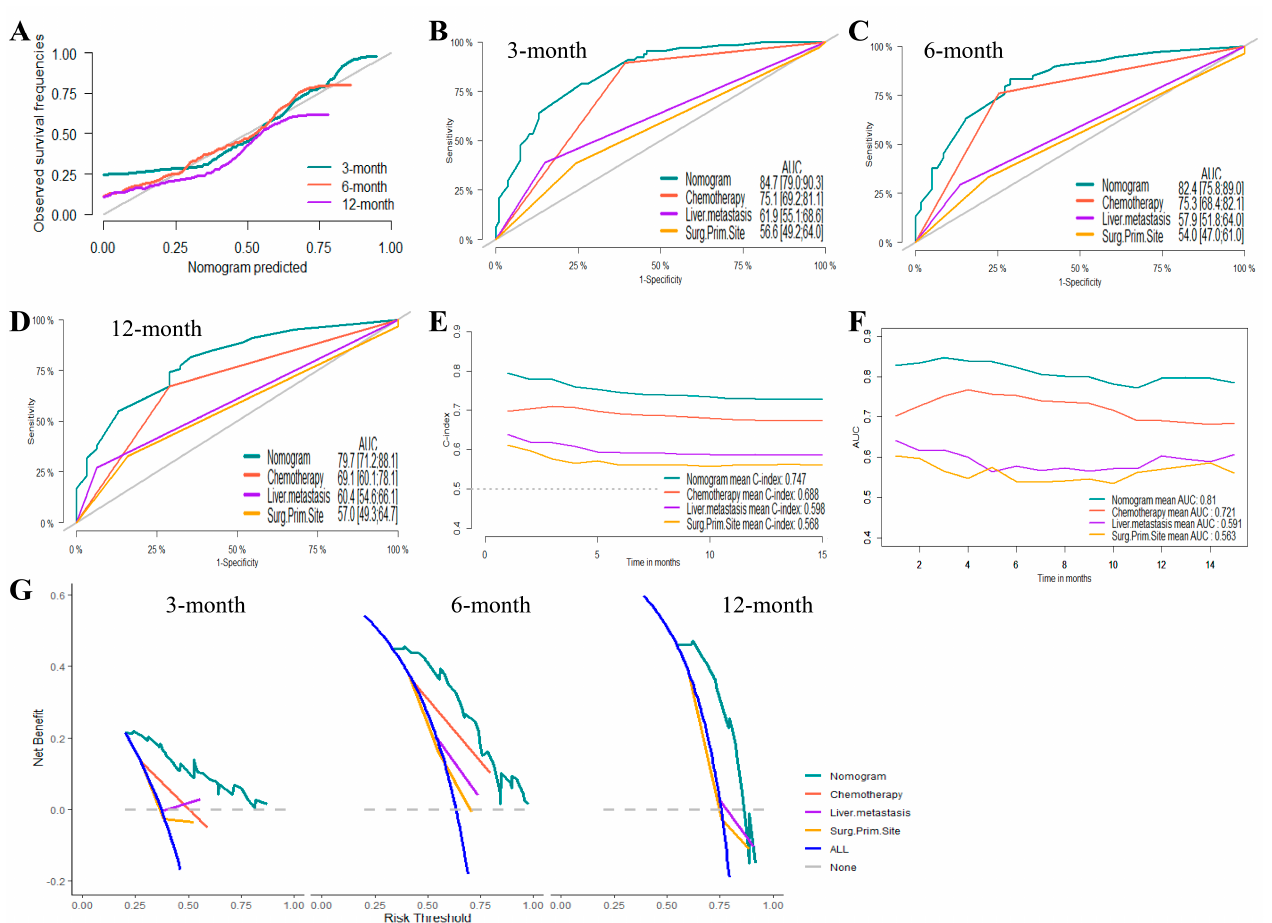
Figure 6. Evaluation of the nomogram on an external testing dataset for cancer-specific survival (CSS). ( A ) 3-, 6-, and 12-month calibration plots of nomogram; ( B ) 3-month; ( C ) 6-month; and ( D ) 12-month area under the curve (AUC) for receiver operating characteristic (ROC) curves of nomogram, Chemotherapy, liver metastasis, and primary site surgery; ( E ) overall concordance index (c-index) of nomogram, chemotherapy, liver metastasis, and primary site surgery; ( F ) Overall AUC of nomogram, chemotherapy, liver metastasis and, primary site surgery; ( G ) 3-, 6-, and 12-month decision curve analysis (DCA) of nomogram, chemotherapy, liver metastasis, and primary site surgery.